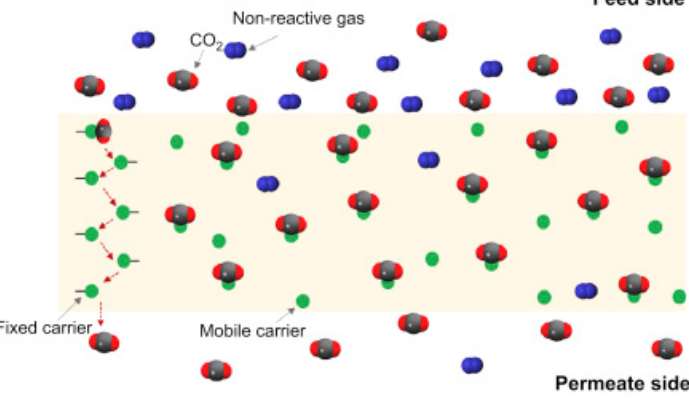
Figure 1. Schematic representation of the facilitated transport mechanism. Reproduced with per- mission from Ref.